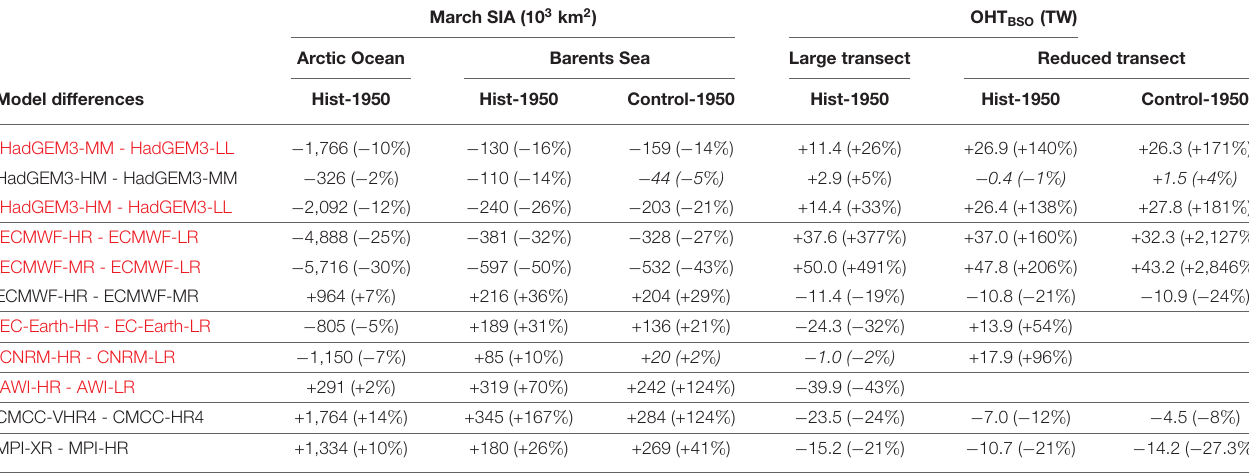
TABLE 3 | Mean differences in March sea-ice area (SIA; both pan-Arctic and Barents Sea) and ocean heat transport (OHT) at the Barents Sea Opening (BSO; both large and reduced transects) between the different configurations of each model, averaged for the record from 1950 to 2014.